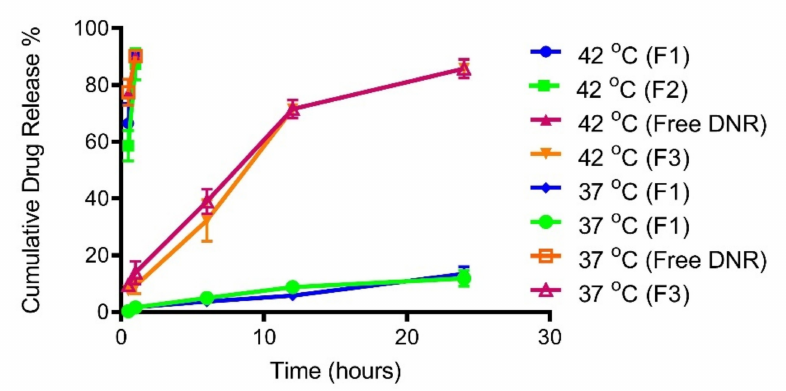
Figure 1. Release profiles of DNR from TSL and non-TSL formulations at 37 ◦ C and 42 ◦ C. Non-TSLs were not influenced by temperature. Values represent mean ± standard deviation ( n =